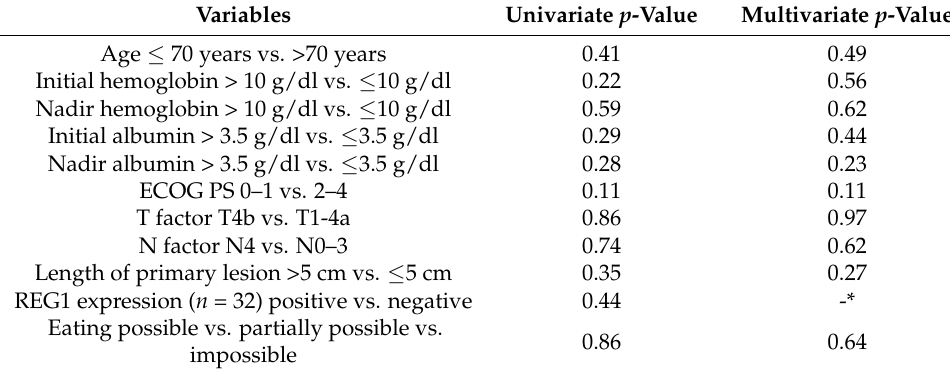
Table 4. Univariate and multivariate analyses of factors that are associated with overall survival. Variables